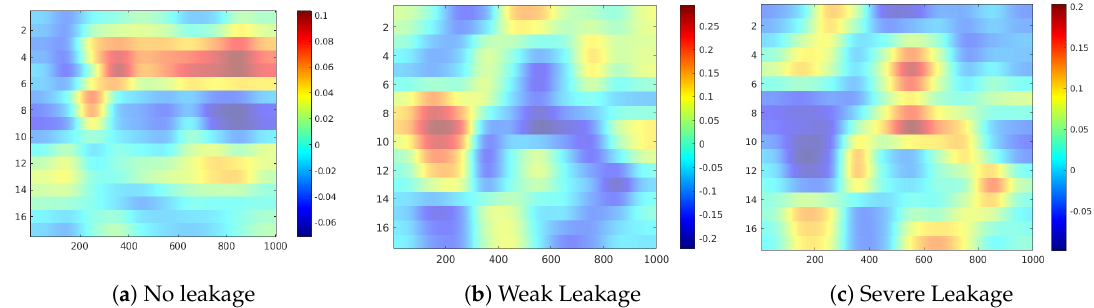
Figure 9. Feature attribution heatmap for the Internal Pump Leakage condition.